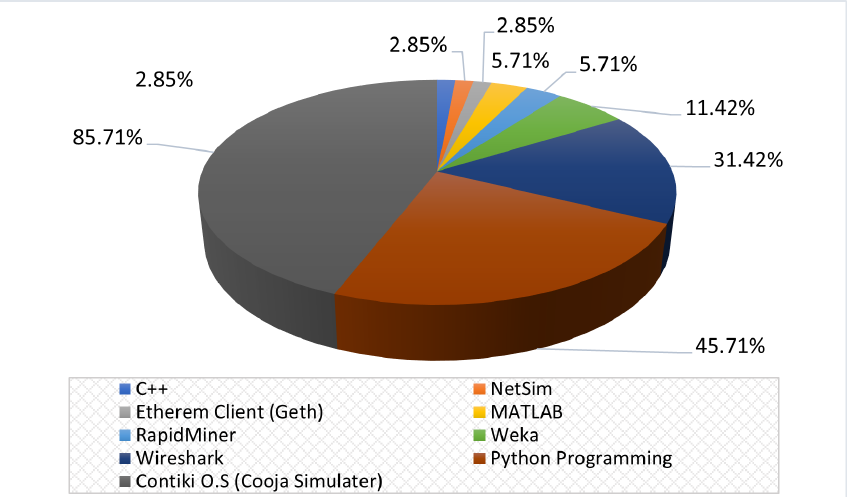
Figure 9. Distribution percentages of the used tools and network simulators in the existing studies.